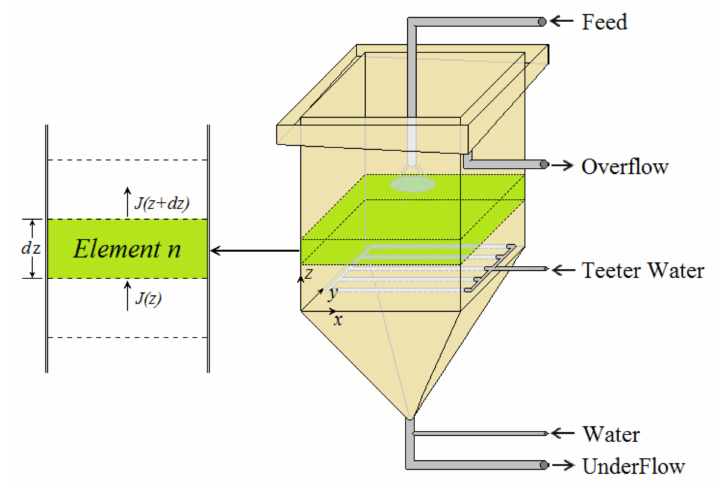
Figure 2. Elements of hydraulic